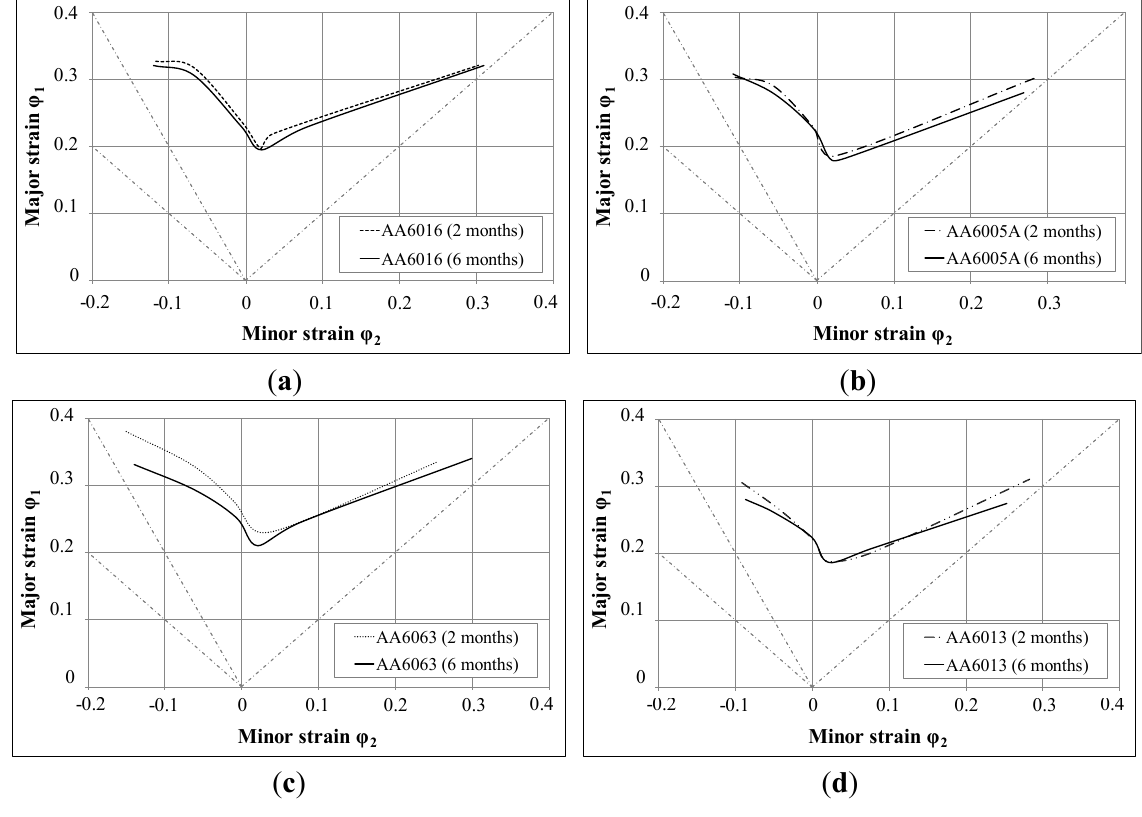
Figure 11. Forming limit curve of ( a ) AA6016; ( b ) AA6005A; ( c ) AA6063; ( d ) AA6013 in temper T4* for a sheet thickness of 1.0 mm measured two and six months after sheet